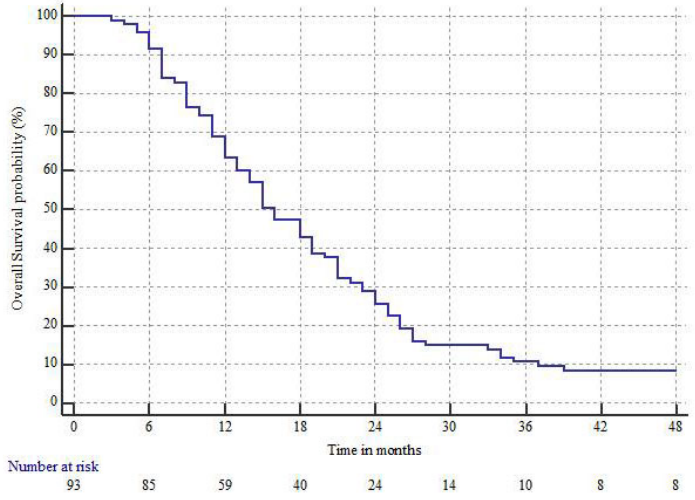
Figure 3. Overall survival (OS).